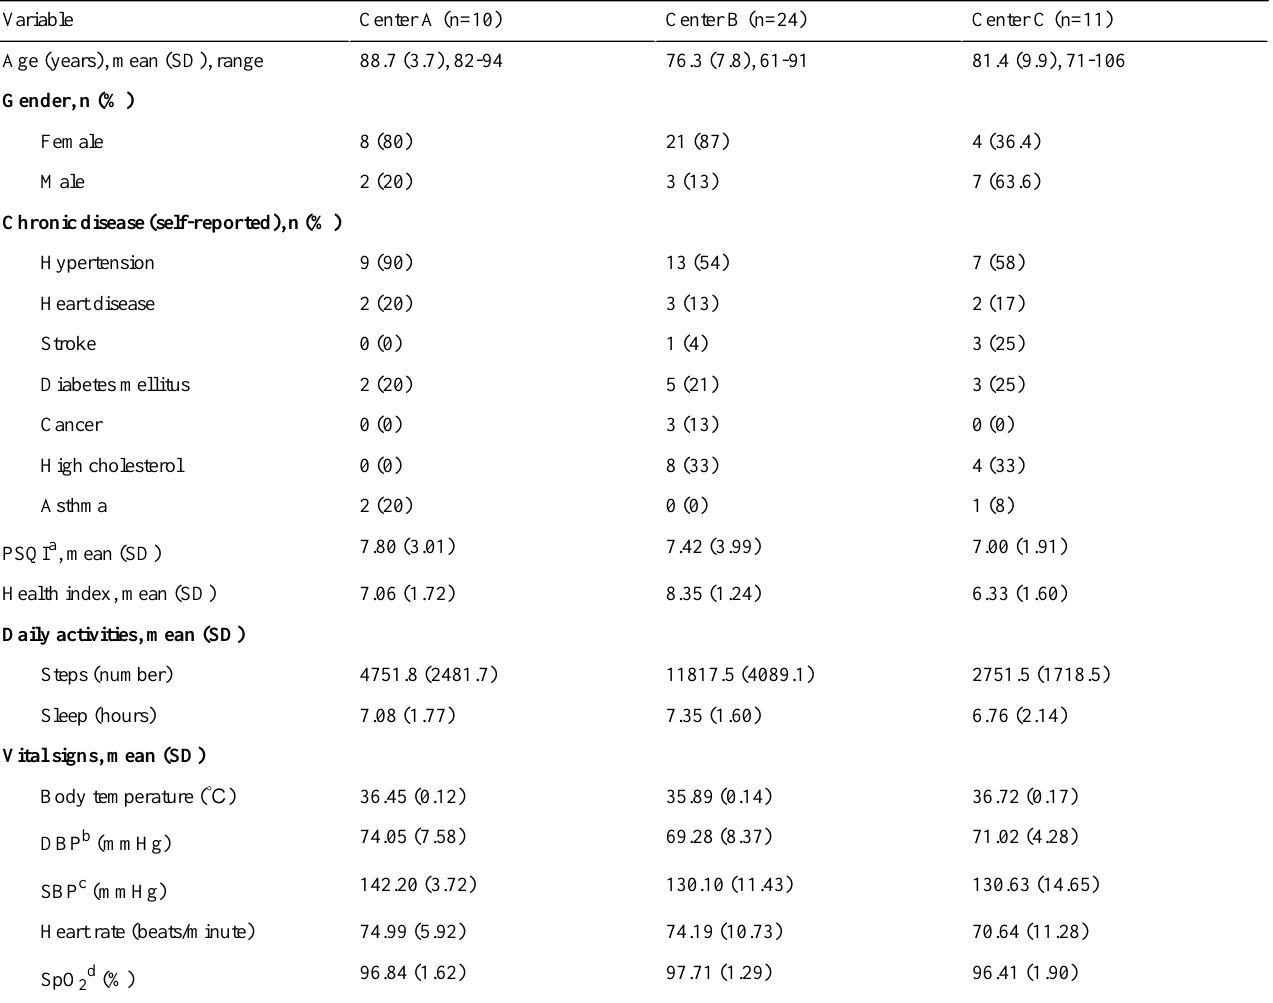
Table 1. Demographics, daily activities, and vital signs of the 45 participants stratified by